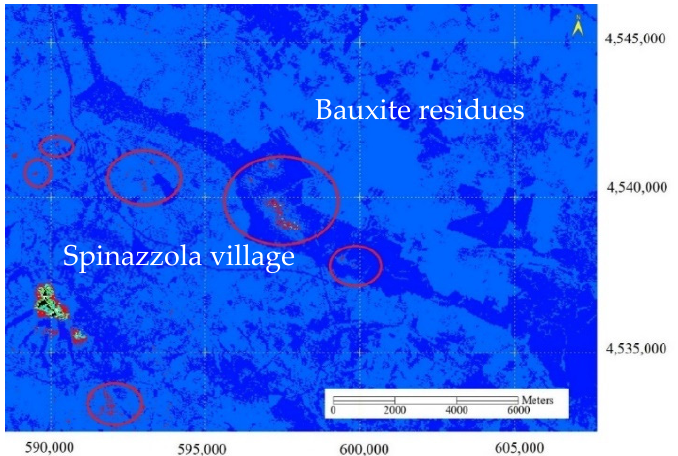
Figure 5. Band ratio analysis (iron oxides: Band28/Band8) detecting bauxite potentials in the Spinazzola rural area (PRISMA).